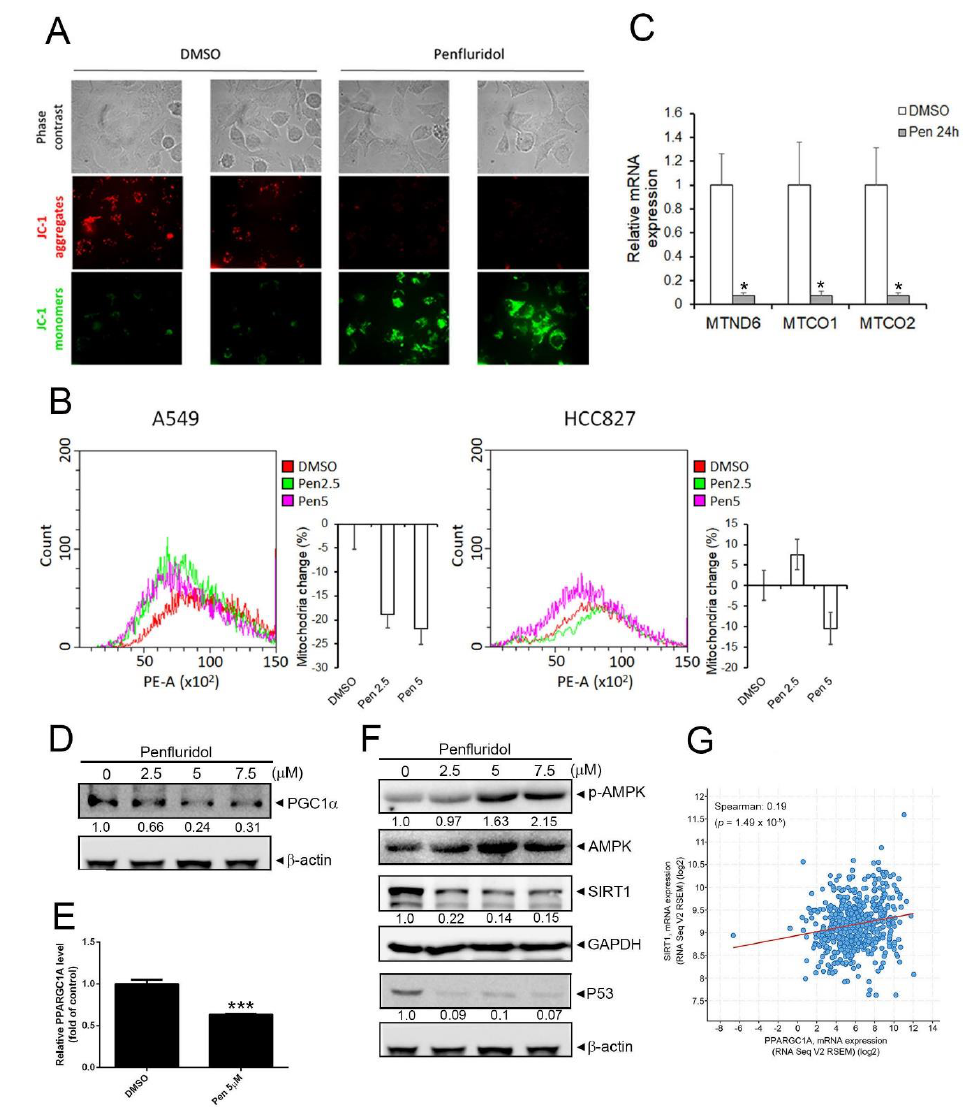
Figure 2. Penfluridol decreases mitochondrial activity and mass in human non − small cell lung cancer (NSCLC) cells via targeting peroxisome − proliferator − activated receptor co − activator − 1 α (PGC − 1 α ). ( A ) Fluorescent JC − 1 images of the mitochondrial membrane potential in A549 cells treated with vehicle or penfluridol (5 µ M) for 24 h. The red − to − green fluorescence ratio indicates a decrease in functional mitochondria with the membrane potential. ( B ) For the flow cytometric analysis, cells were stained with MitoTracker Red H2XRos (which fluoresces upon oxidation in respiring mitochondria). Representative histograms (left panel) and bar graph (n = 3) (right panel) of the flow cytometric analysis between vehicle − and penfluridol − treated A549 and HCC827 cells are depicted. ( C , E ) A549 cells were treated with vehicle or penfluridol (5 µ M) for 24 h to detect mRNA levels of MTND6, MTCO1, MTCO2 ( C ), and PPARGC1A ( E ) using an RT − qPCR. Quantitative results of indicated mRNA levels were adjusted to GAPDH mRNA levels. * p < 0.05, *** p < 0.001, compared to the vehicle group. ( D , F ) A549 cells were treated with vehicle or penfluridol at indicated concentrations for 24 h. Cells were harvested and then subjected to a Western blot analysis to detect PGC − 1 α ( D ), phosphorylated (p) − AMPK, sirtuin 1 (SIRT1), and p53 levels ( F ). GAPDH, β − actin, or AMP − activated kinase (AMPK) was used as an equal loading control. Western blots shown are representative results from 3 independent experiments. ( G ) Correlation analysis of the TCGA lung cancer database (TCGA, PanCancer Atlas) using the cBioPortal revealing a positive correlation between PPARGC1A and